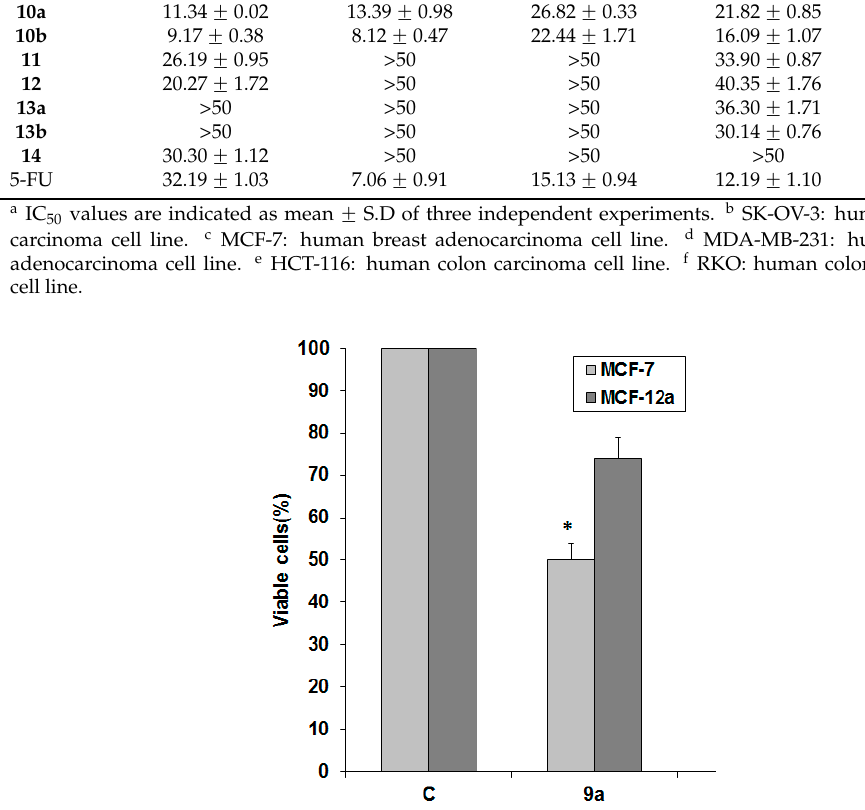
Figure 3. Cytotoxicity of compound 9a on human breast cancer cells MCF-7 and non-tumorigenic breast epithelial cells MCF-12a. WST-1 Assay was performed on MCF-7 and MCF-12a after treatment with 2 μ M of compound 9a for 24 h. Each data point was an average of results from three independent experiments performed in triplicate and presented as M ± SD. Significant differences between the control and test compounds are indicated by * (* p ˂ 0.05).